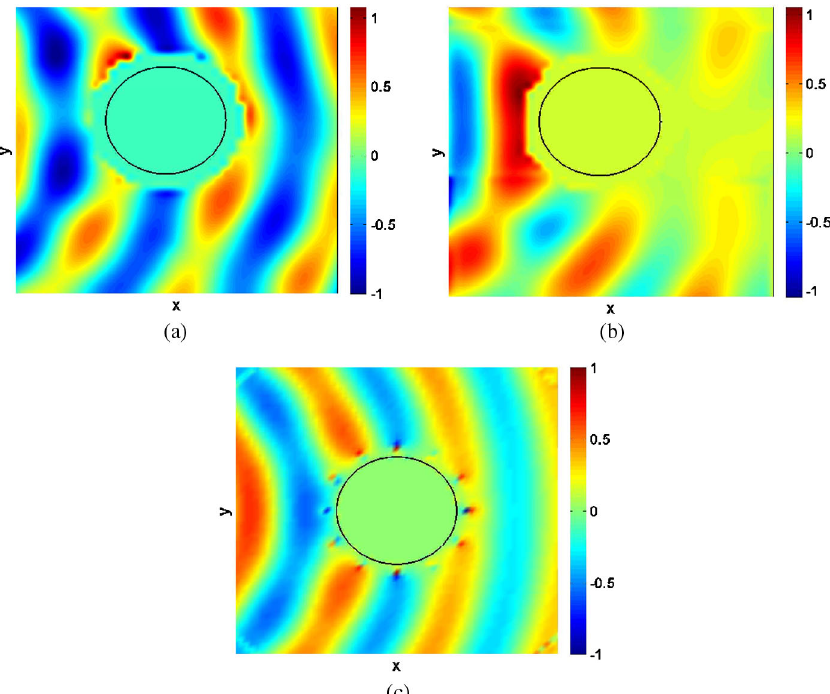
FIG. 8. (a) The measured real part of the total electric field created by the magnetic-dipole array and the incident field from the monopole antenna in the presence of the aluminum cylinder. Note the shadow region has disappeared, and cylindrical wave fronts have been restored. (b) The measured total electric field for the scattering off of the bare aluminum cylinder, replotted again from (a). Note the shadow region. (c) The simulated cloak using ideal magnetic dipoles, found using COMSOL